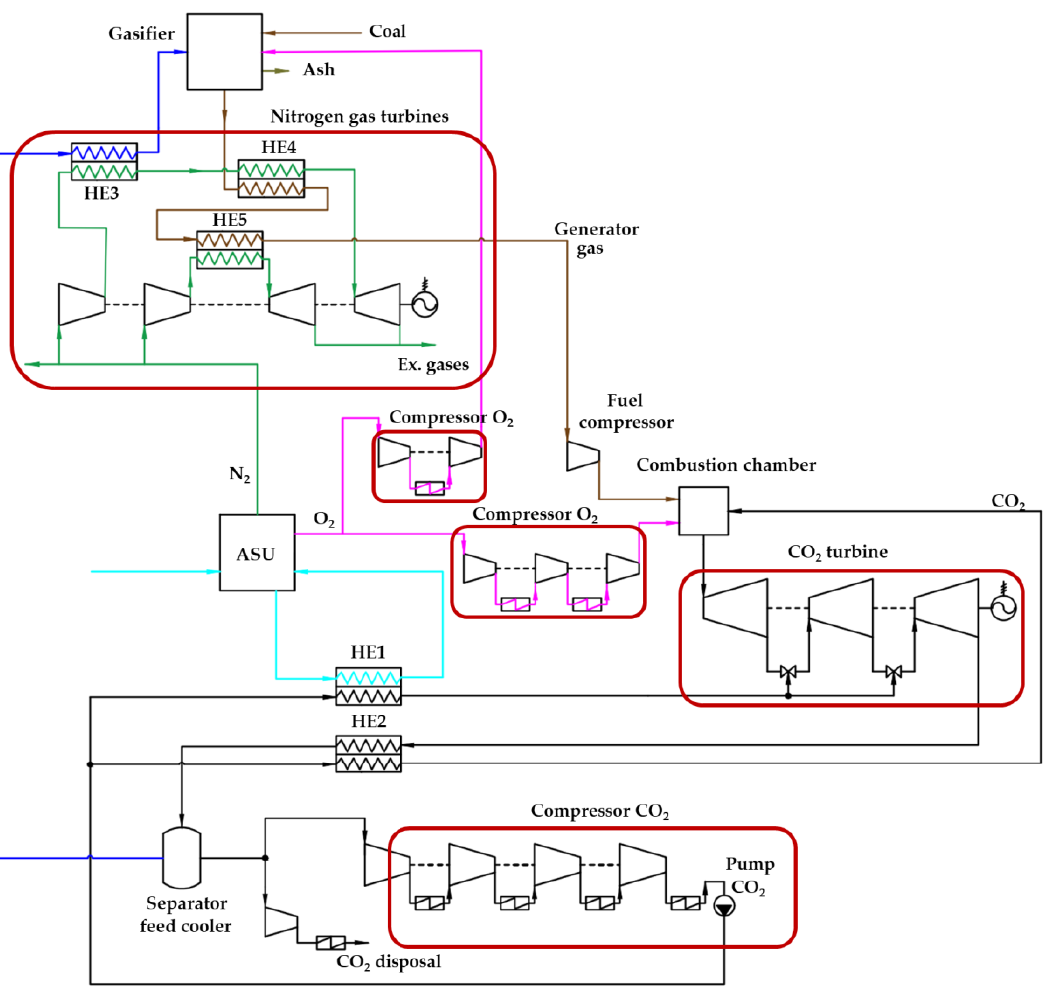
Figure 1. Scheme of the Allam cycle with coal gasification and additional nitrogen gas turbine units. Table 2. Initial data for modeling.